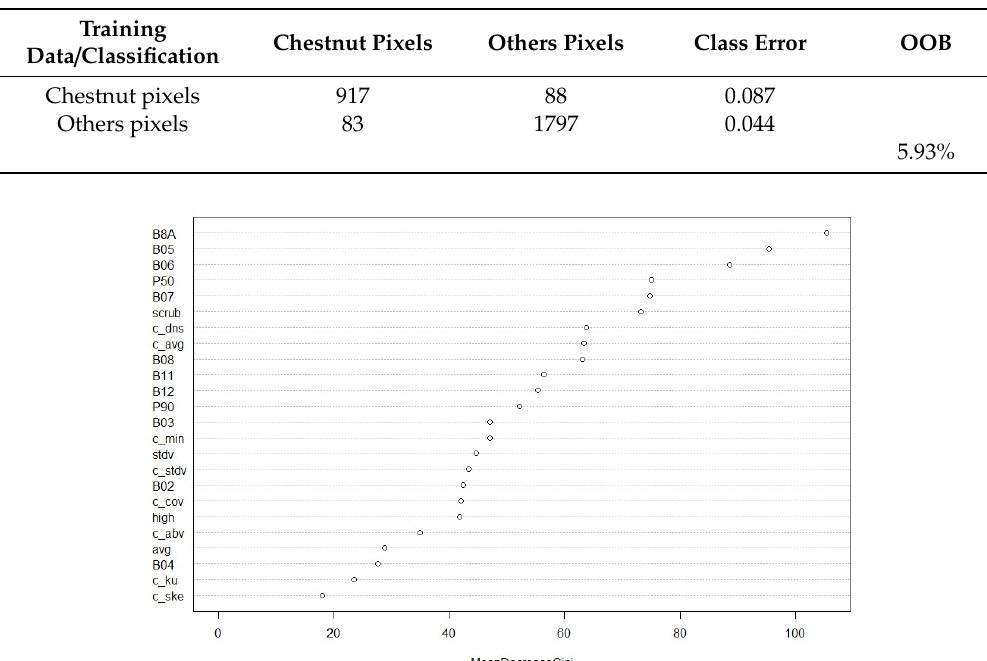
Figure 5. Plot of the Mean Decrease in Gini for each of the variables in Model 1.